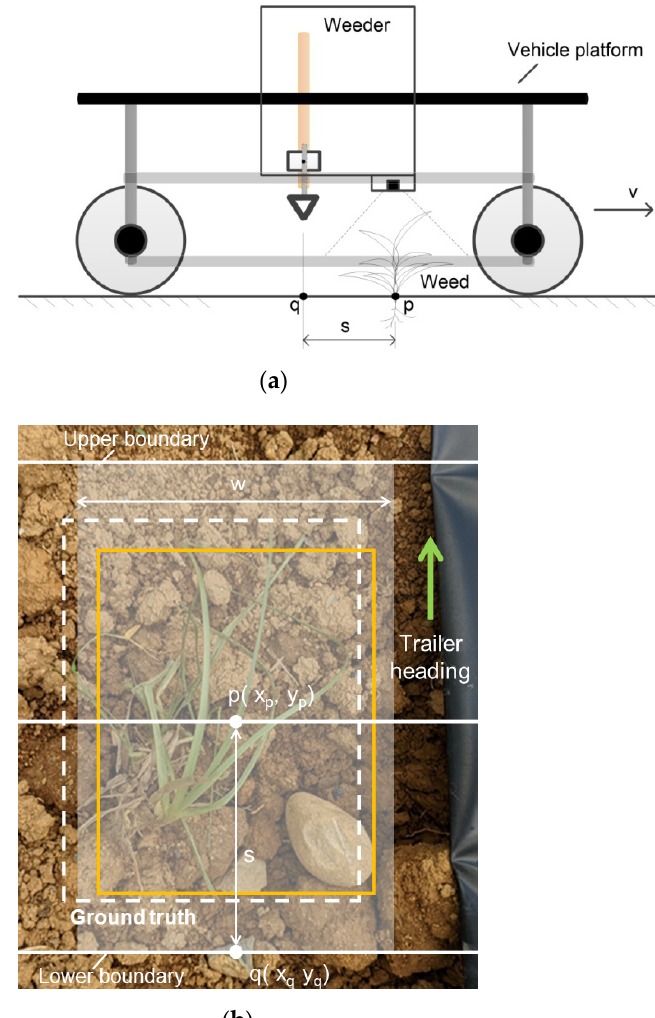
Figure 4. Operation concept of the weeding process of the weeder. ( a ) The relationship between the two-dimensional coordinate points of the weeding tool, the camera and the weeds; ( b ) Frame selection of weed objects in the snapshot image and description of the range of weeding.